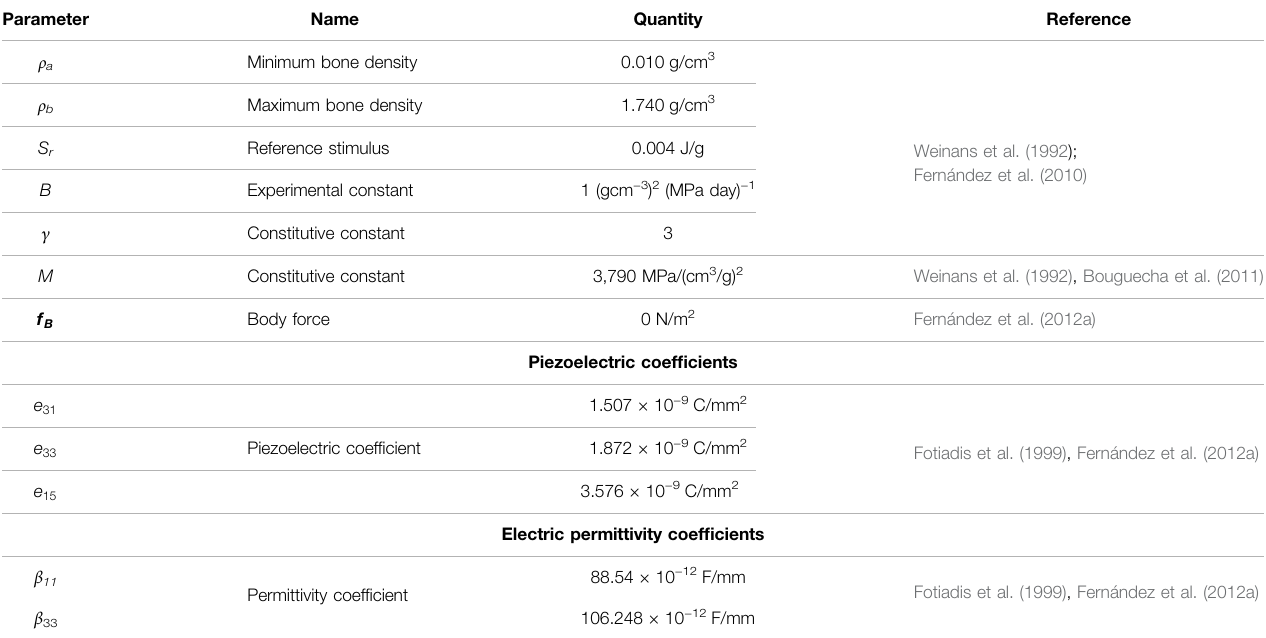
TABLE 1 | Values of the parameters used in the fi nite element analyses.